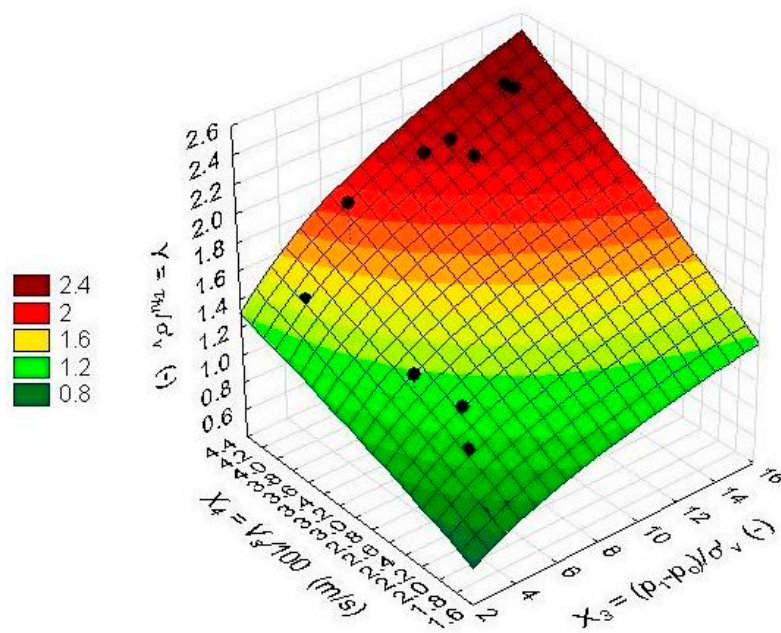
Figure 9. Graphic presentation of the proposed relationship (Equation 22).